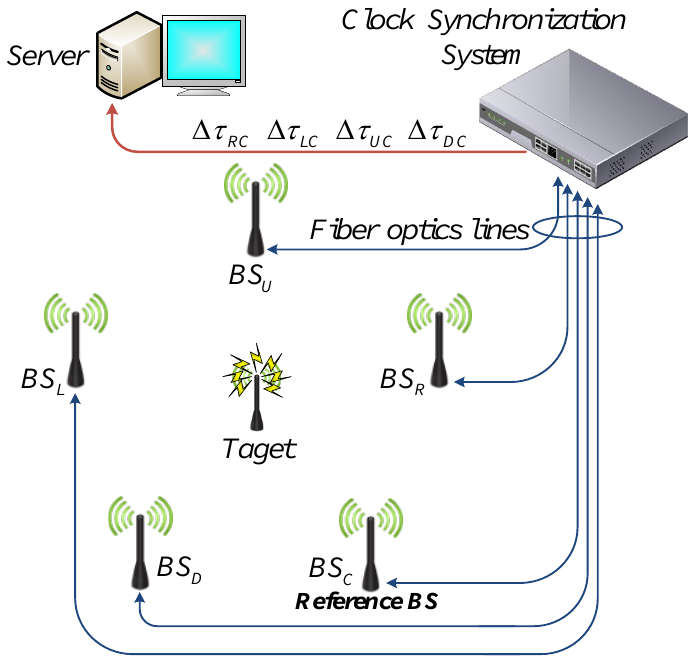
Figure 1. Block diagram of the time difference of arrival (TDoA)-based positioning system with 5 base stations (BSs).